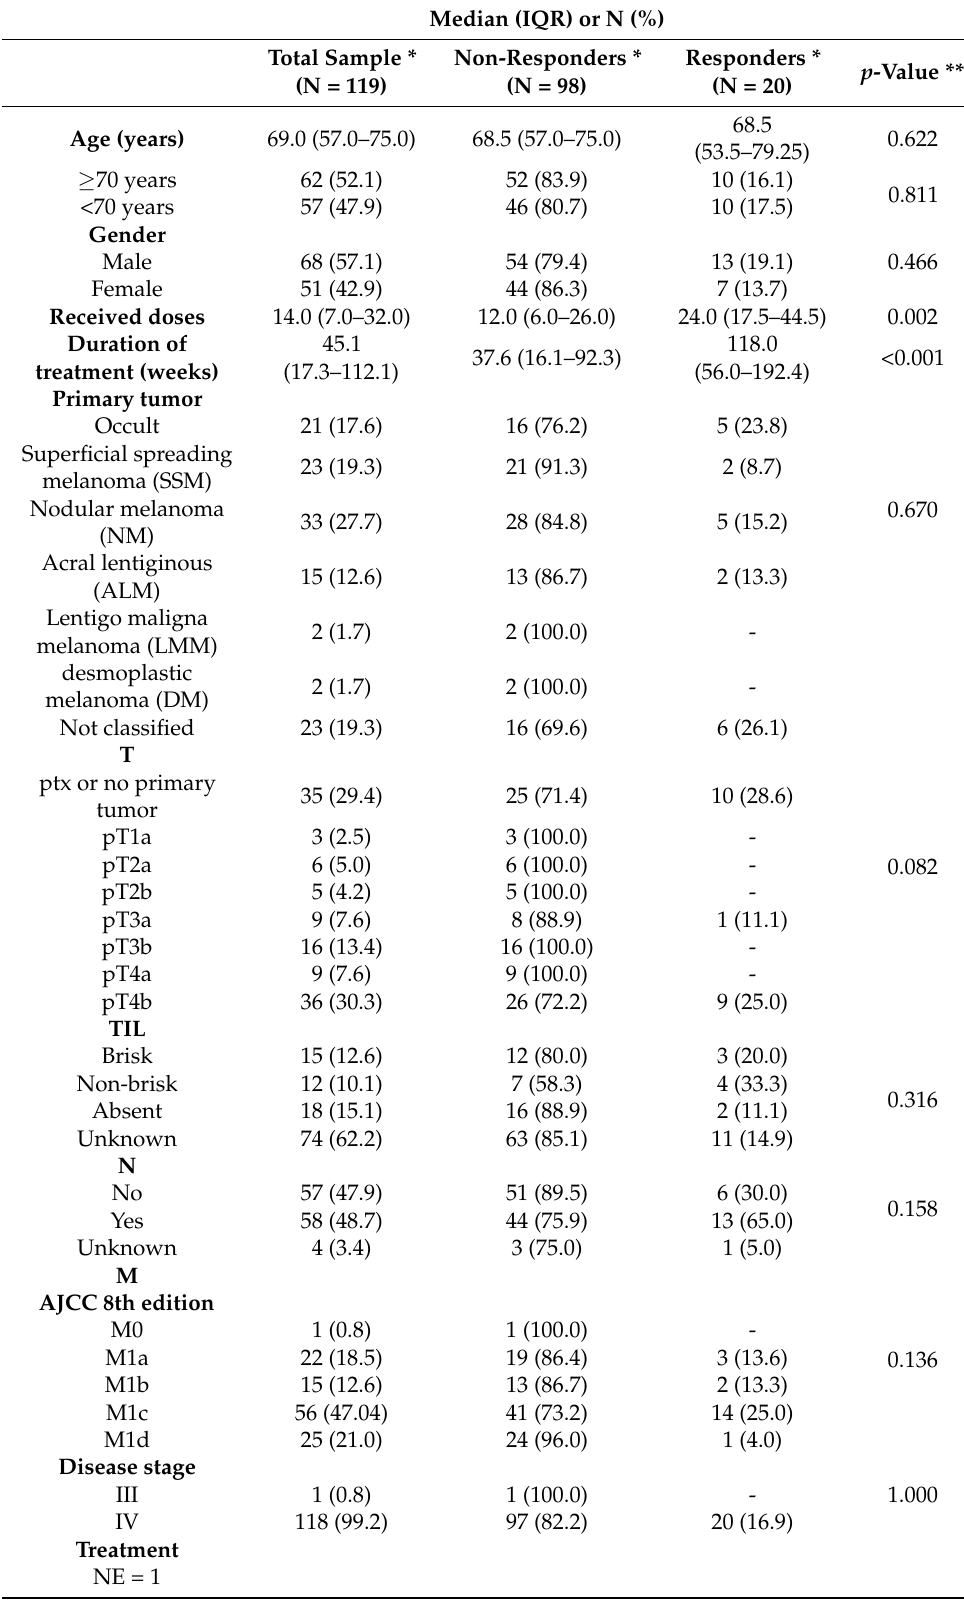
Table 1. Demographic and clinical characteristics of